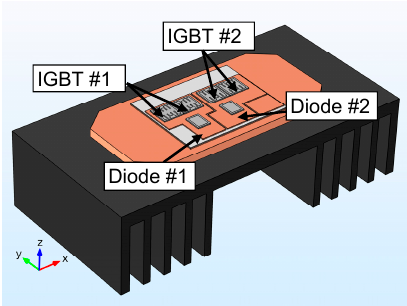
Figure 1. Comsol Multiphysics 3-D structure of the IGBT power module under test, equipped with an aluminum heatsink in free convection.